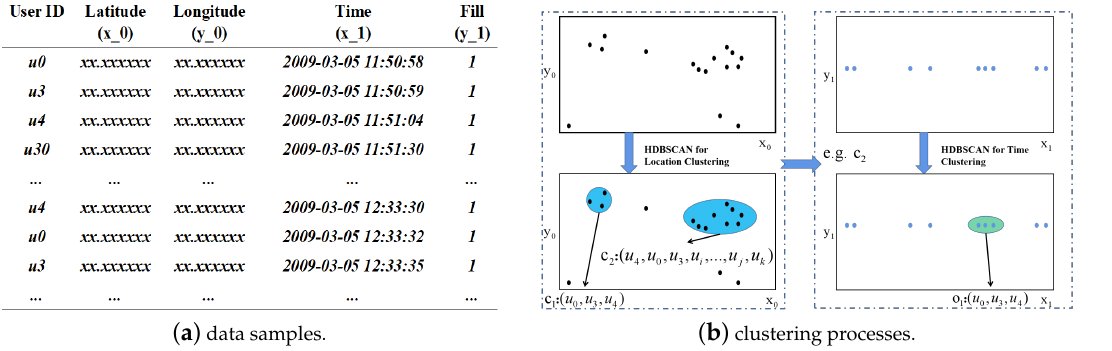
Figure 4. Trajectory Clustering for Discovering Time and Location Potential